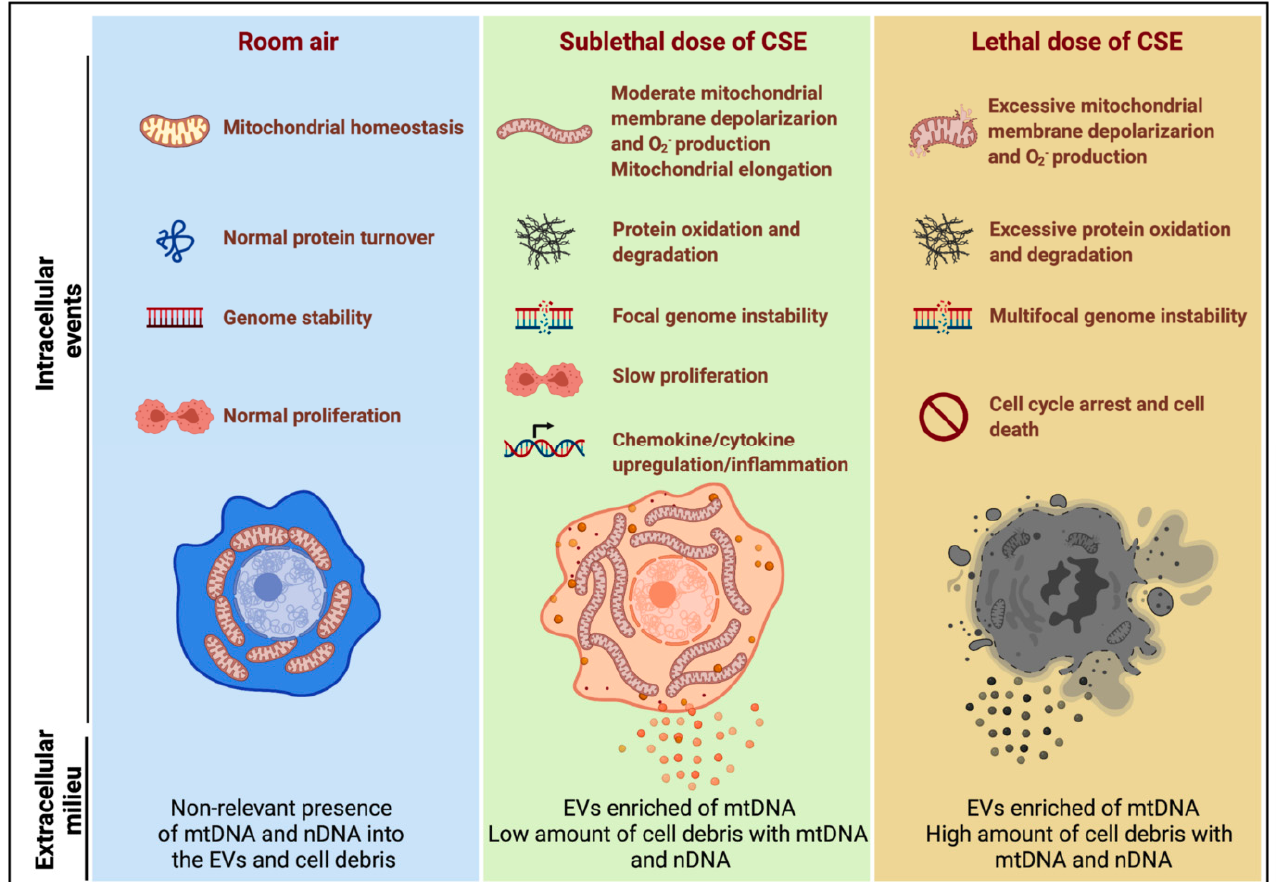
Figure 8. Model summarizing the effects of sublethal (10%) or lethal (20%) doses of CSE with extracellular mtDNA and nDNA release. A sublethal dose of CSE promoted moderate mitochondrial membrane depolarization, increased superoxide (O 2 − ) production and oxidative stress, slowed cell proliferation, and triggered mtDNA release by extracellular vesicles (EVs). This condition is exacerbated in cells exposed to a lethal dose of CSE, in which mtDNA and nDNA are mainly released by the high amount of cell debris.